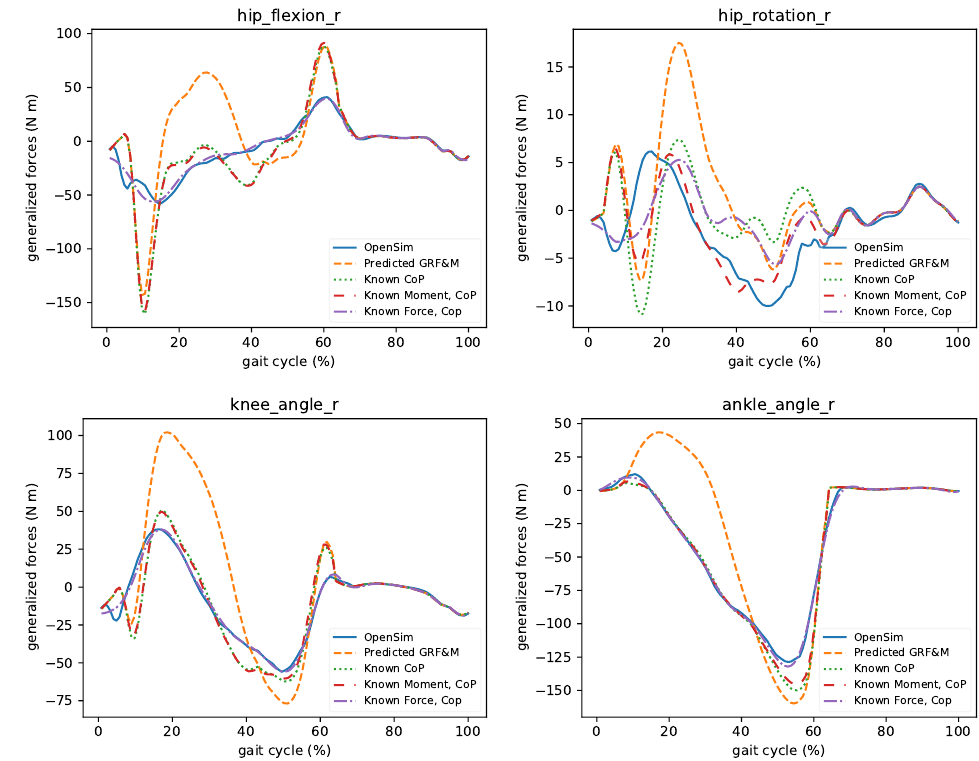
Figure 10. The influence of estimated GRF&M on the generalized forces computed through ID. Predicted GRF&M greatly affect the calculated joint moments. A good estimate of CoP improves the predictions of ankle and knee moments. Hip flexion requires accurate estimation of both CoP and forces, while hip rotation CoP and